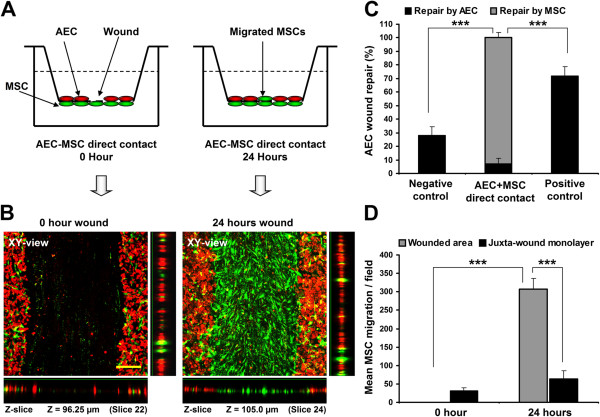
hMSC migrate to the AEC wound sites and close wound gaps. (A) Schematic diagram showing two-cell direct contact co-culture wound repair model using 3 μm porous transwell system. (B) Laser scanning confocal micrographs of AEC-MSC direct contact co-culture wound repair model at 0 and 24 hours. Red cells are DiI labelled AECs and green cells are DiO labelled hMSCs. Horizontal panels are the Z-slicing through the wound gaps and the vertical panels are Z-slicing through the corresponding juxta-wound monolayers. Appearance of green signals in the same plane of red signals in the in the Z-slice after 24 hours confirms hMSC migration to the AEC wound site. (C) AEC-MSC direct contact co-culture vs. negative and positive controls. Black and grey bars indicate AEC and hMSC contribution to repair, respectively. Negative control represents AEC wound repair in SF-DMEM in mono-culture setting on upper surface of transwell PET membrane. Positive control represents AEC wound repair in 10% FBS supplemented DMEM in mono-culture setting on upper surface of transwell PET membrane. (n = 6; ***p < 0.001). (D) hMSC migration in a direct contact co-culture wound repair system (n = 13; ***p < 0.001). Data presented as mean ± SD. Scale bar, 150 μm.